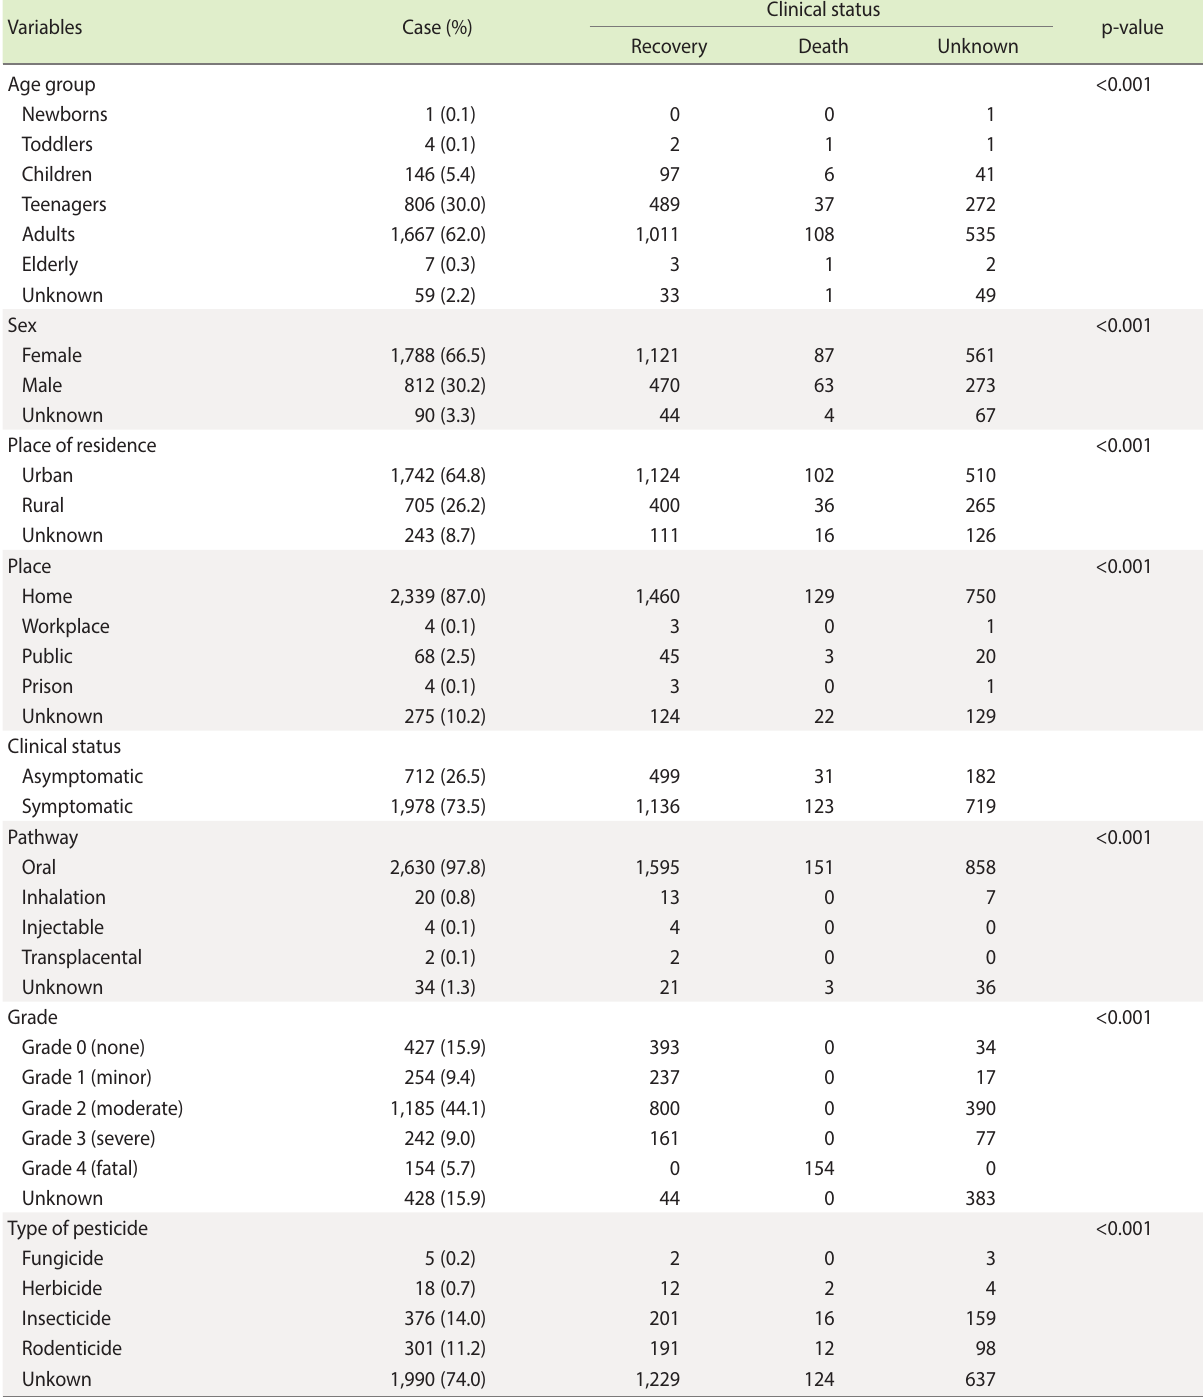
Table 1. Characteristics of the subjects who experienced voluntary pesticide poisoning